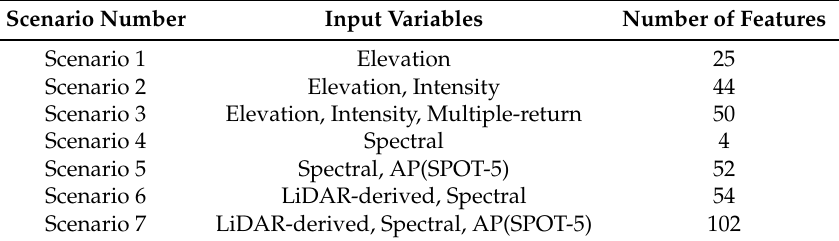
Table 2. Different scenarios involoved in